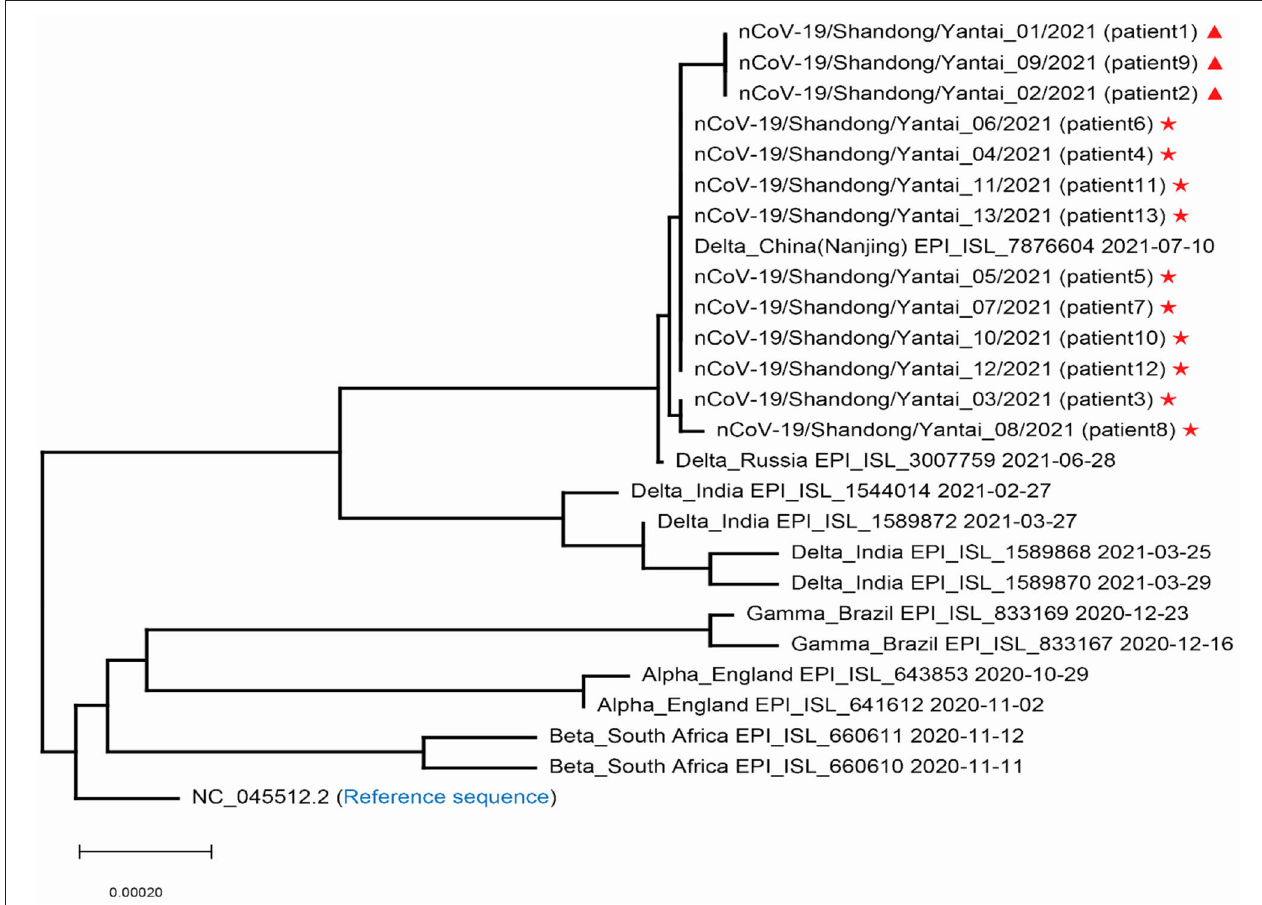
FIGURE 1 | Phylogenetic tree of the SARS-COV-2 sequences in Yantai with other reported sequences. Stars and triangles represent the two transmission routes of COVID-19, respectively in Yantai.